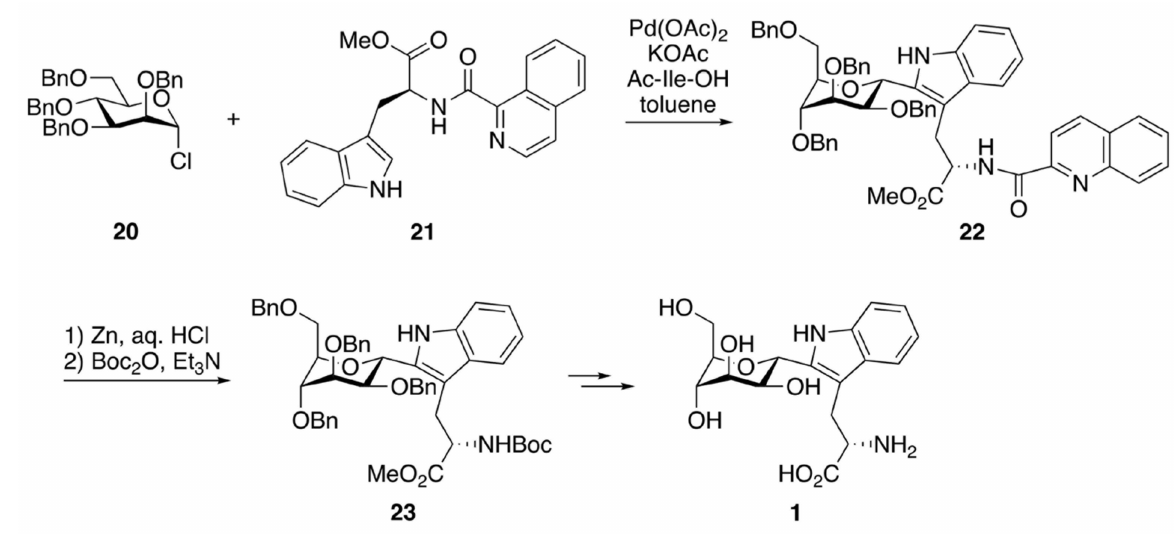
Scheme 4. C -Man-Trp synthesis through quinoline-assisted Pd-mediated reaction.